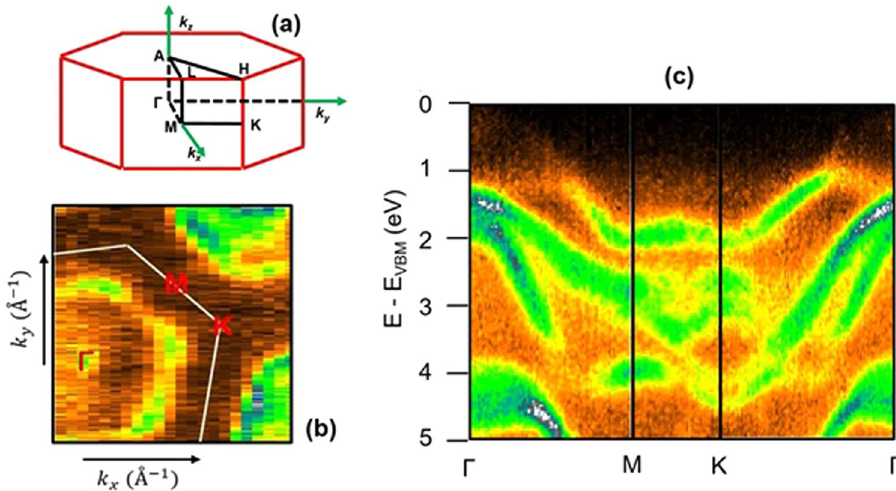
Figure 2. ( a ) Representation of the BZ of β -InSe. ( b ) Constant energy map at 1 eV below the VBM. ( c ) Experimental band structure along the high-symmetry directions. The energy scale was set to zero at